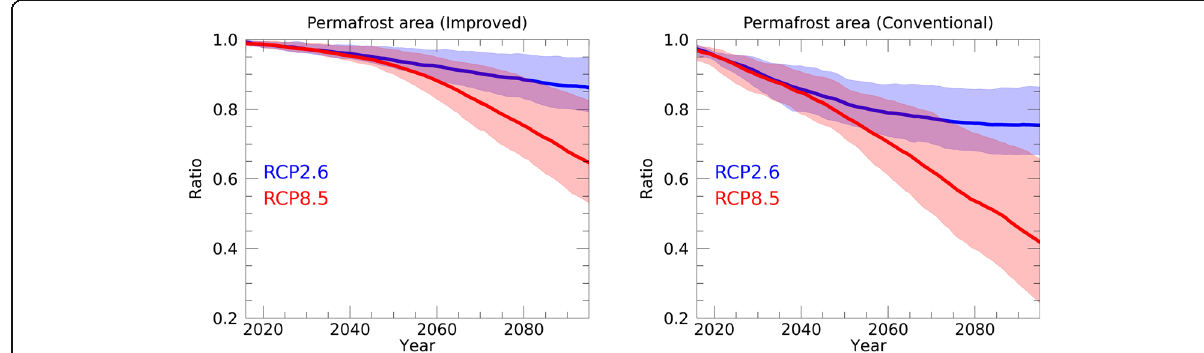
Fig. 6 Changes in the total permafrost area across the world as projected by the study ’ s future simulations. The width of the line represents the maximum and minimum values of the simulated results forced by the five GCMs; the average value is represented by the bold lines. The simulations with the improved (left) and conventional (right) schemes under RCP2.6 (blue) and RCP8.5 (red) scenarios are shown. Values on the vertical axis were determined by setting the permafrost area at the initial year (2005) of the future simulations to